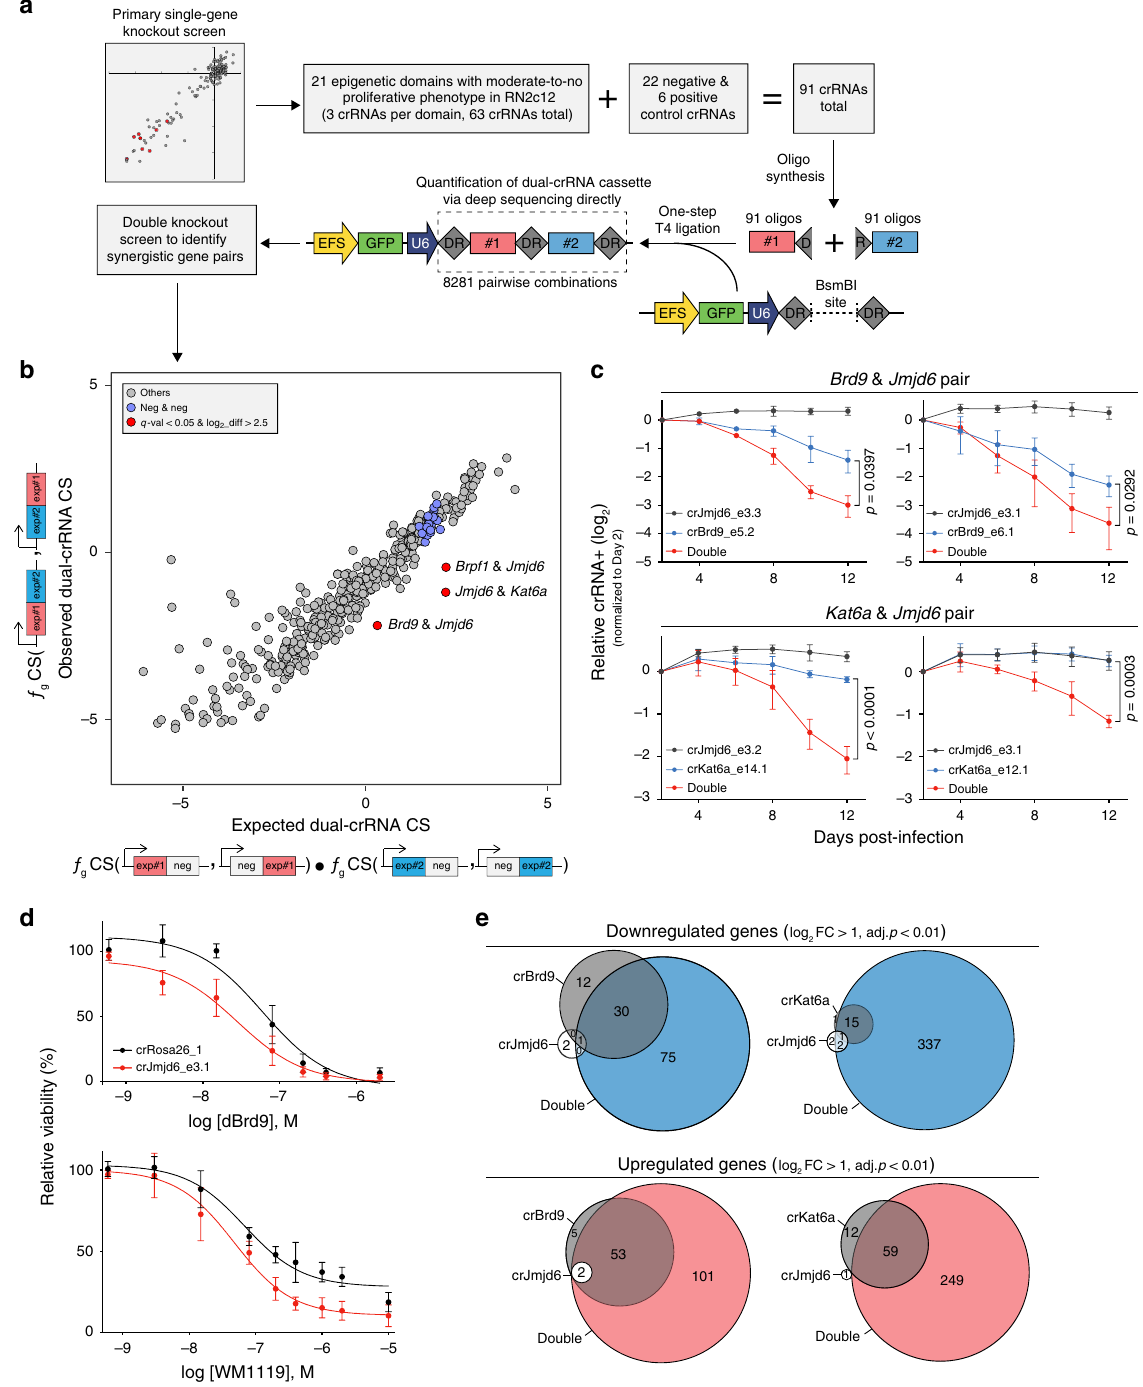
combinatorial genetic screens across cancer types and disease models for therapeutic target